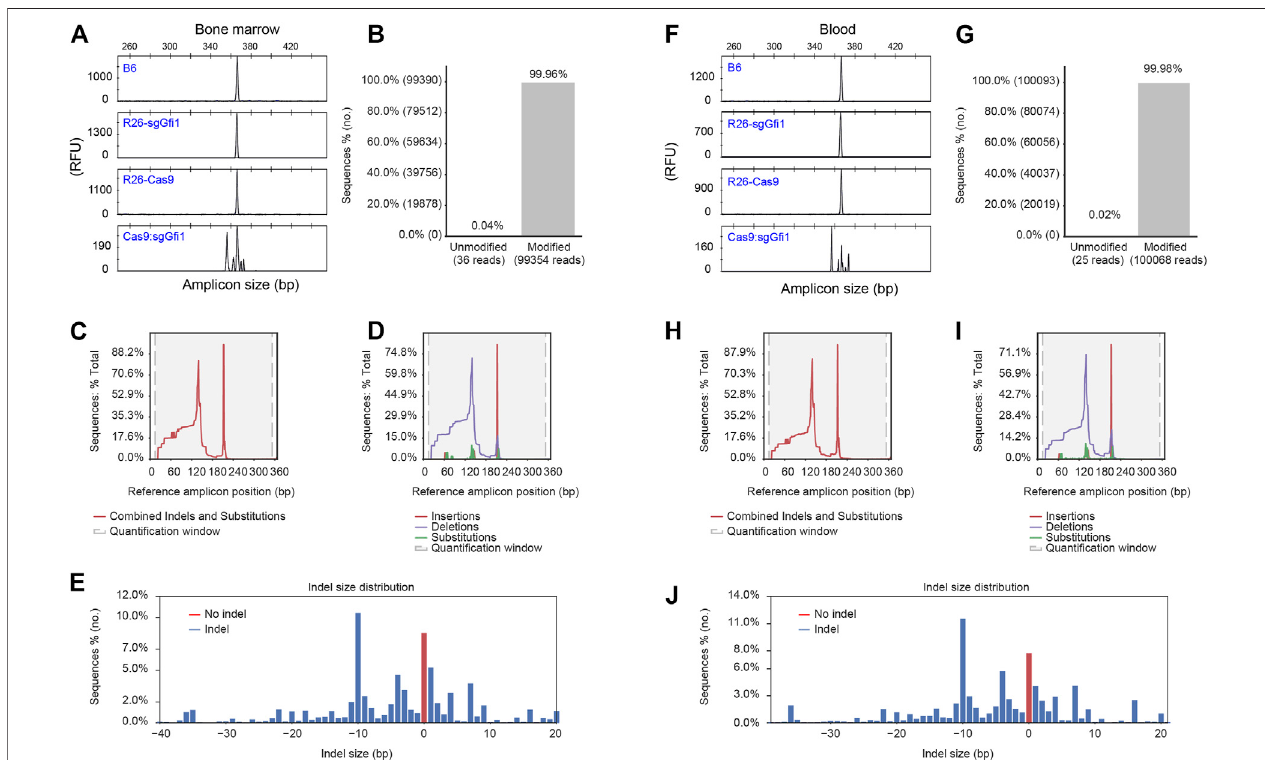
FIGURE 3 | Detection of CRISPR/Cas9-mediated genetic modi fi cation of G fi 1 gene. (A) Bone marrow cells were isolated and subjected to red blood cell lysis before extraction of genomic DNA and PCR ampli fi cation using 5 ’ FAM labeled oligonucleotide. The PCR products from G fi 1 targeted Cas9:sgG fi 1 mice and control mice were analyzed by fPCR-CAE. (B) Bone marrow cells were used for the analysis of DNA modi fi cation in G fi 1 targeted Cas9:sgG fi 1 mice. The same PCR primers as used in (A) without 5 ’ FAM labeling were used to amplify G fi 1 targeted Cas9:sgG fi 1 mice, and the PCR products were analyzed by NGS to detect both unmodi fi ed and modi fi ed sequences by alignment ofthe reads to a wild-type reference. (C) Bone marrow cells were used for combined analysis ofthe localization of the DNA modi fi cations, which included insertions, deletions, and substitutions. (D) Bone marrow cells were used for the analysis of the localization of the DNA modi fi cations in a separate manner, which included insertions, deletions, and substitutions, respectively. (E) Bone marrow cells were used for frequency analysis of indels with difference sizes occurring at the targeted G fi 1 locus, and the red bar represents reads without size change. (F – J) Cells from peripheral blood were used for genomic DNA preparation, and the analyses of G fi 1 locus in the targeted mice wereperformed in the same way as the bone marrow samples. WT B6, Rosa26 U6- sgRNA-G fi 1 (Rosa26-sgG fi 1), and Rosa26-Cas9 mice were used as negative controls for (A,F) . RFU: relative fl uorescent unit.